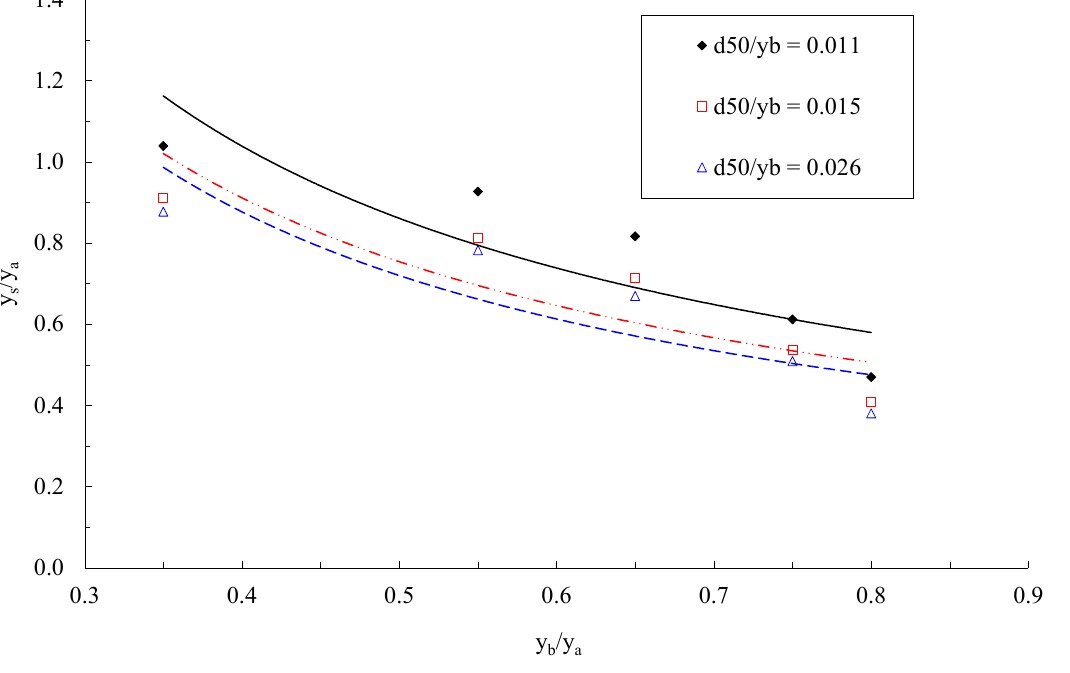
Figure 8. Relative scour depth y s / y a with the relative bridge opening for different relative median bed materials ( d 50 / y b ).